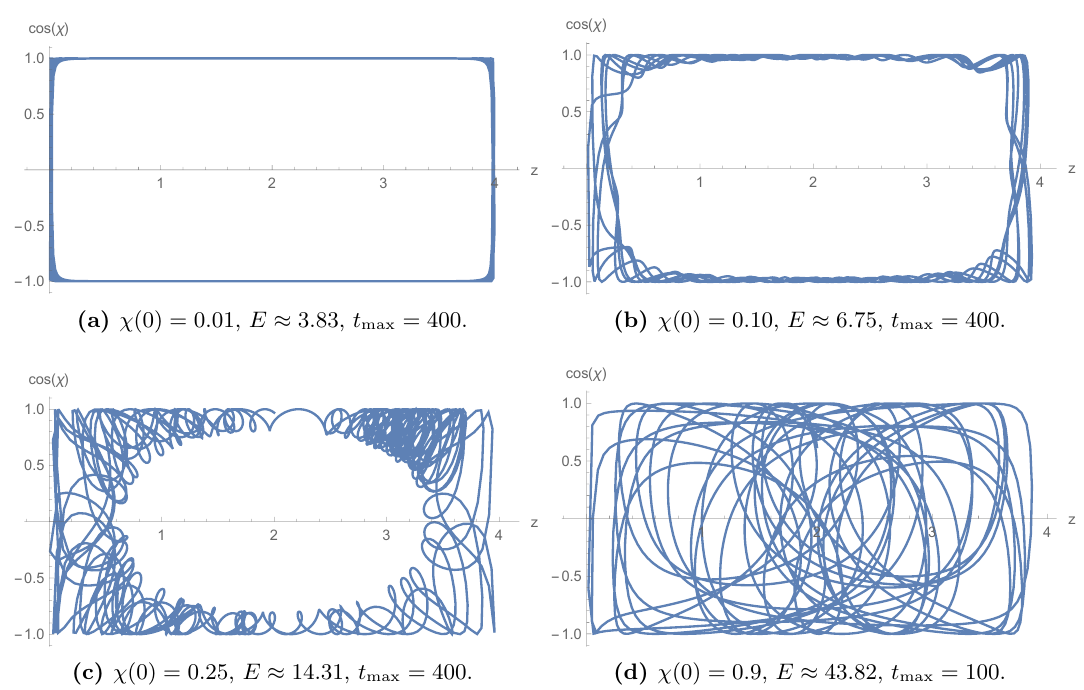
Figure 8. Di(cid:11)erent trajectories in the ( z; (cid:31) )-plane for a string-embedding of the form in eq. (3.3) on the background in (2.7), we run the evolution up to t = t max and only change the initial condition (cid:31)